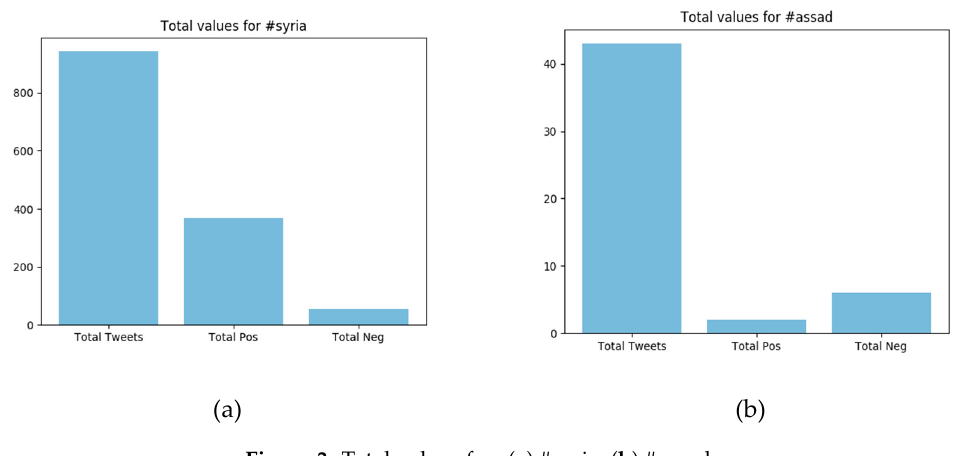
Figure 3 Total values for: ( a ) #syria; ( b ) #assad. Figure 3. Total values for: ( a ) #syria; ( b )